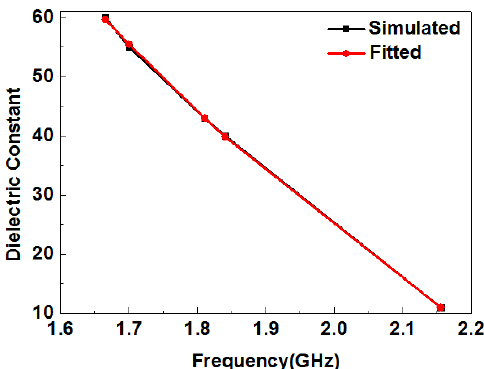
Figure 15. Simulated and fitted curve of the resonant frequencies of ethanol – water mixtures at different concentrations and their dielectric constants.